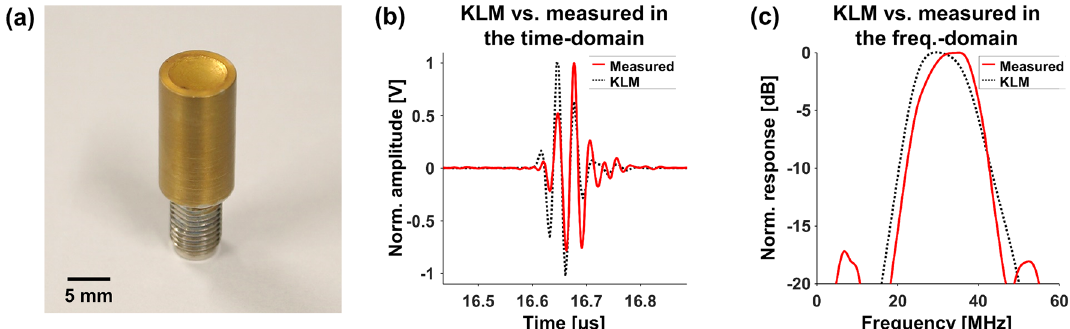
Figure 1. Fabricated US transducer and its specifications. ( a ) Photograph of the fabricated US transducer. Pulse-echo impulse response comparing to the KLM simulation in the ( b ) time-domain and ( c ) frequency- domain. (plotted by: MATLAB R2018a—https:// www. mathw orks. com/ produ cts/ matlab.